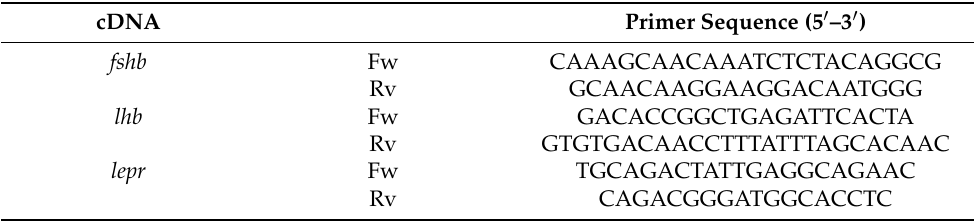
Table 2. Primer sequences used in RNA-probe